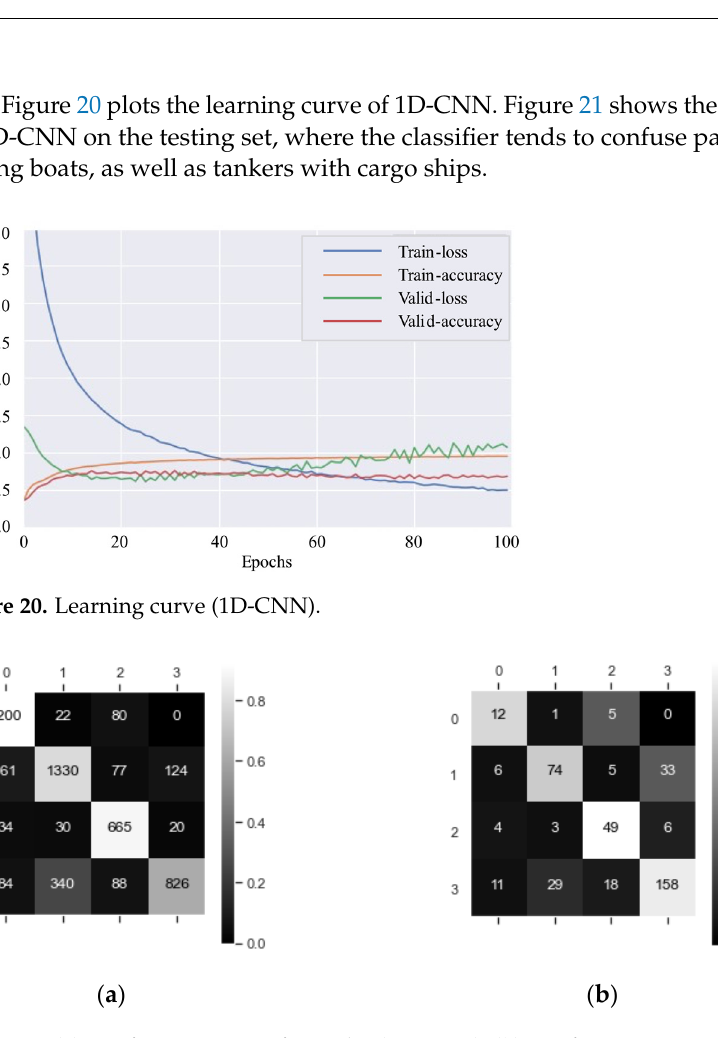
Figure 21. ( a ) Confusion matrix of samples (1D-CNN); ( b ) Confusion matrix of ships (1D-CNN).